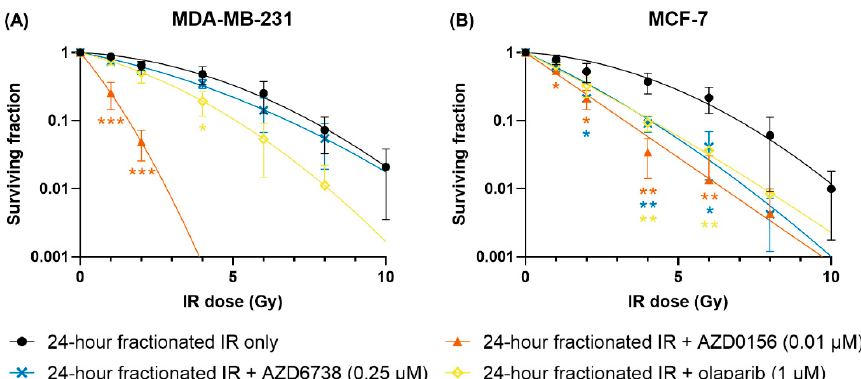
Figure 6. IR dose fractionation enhances the radiosensitizing effect of DDR inhibitors. ( A ) MDA- MB-231 and ( B ) MCF-7 cells were treated with AZD0156 (0.01 µM), AZD6738 (0.25 µM) or olaparib (1 µM) one hour prior to 24-h fractionated irradiation at 1 to 8 Gy, then cell survival was quantified with clonogenic assays. Survival curves of cells treated with 24-h fractionated IR only from previous experiments were displayed for comparison. Data are shown as mean ± SD of three independent experiments performed in duplicate or triplicate wells. * p < 0.05, ** p < 0.01, *** p < 0.001 vs. 24-h fractionated IR only.